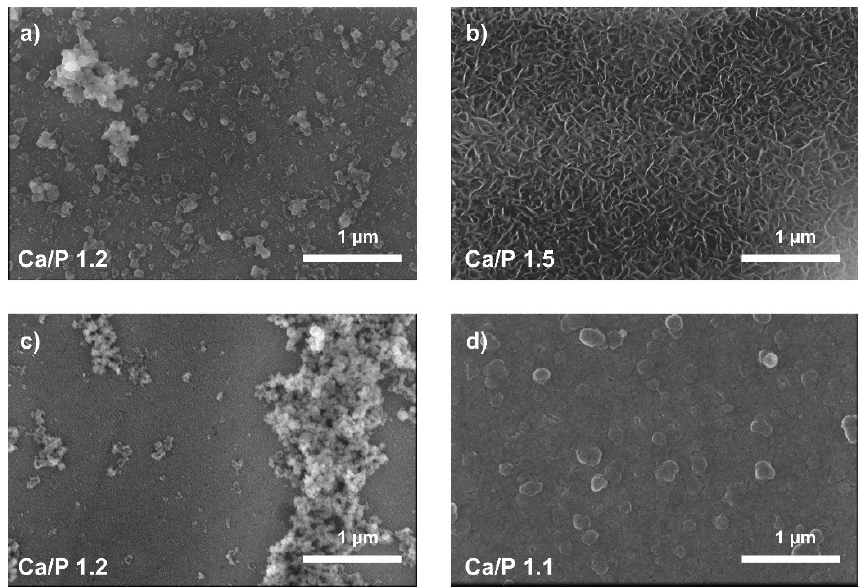
Figure 6. SEM micrographs of apatite formed on: ( a ) undoped TiO 2 , ( b ) Ca_TiO 2 , ( c ) 75Ca25Ag_TiO 2 , and ( d ) Ag_TiO 2 after soaking for 28 days in simulated body fluid (SBF) solution (detector TLD, mag 50,000×, bar 1 μ m).